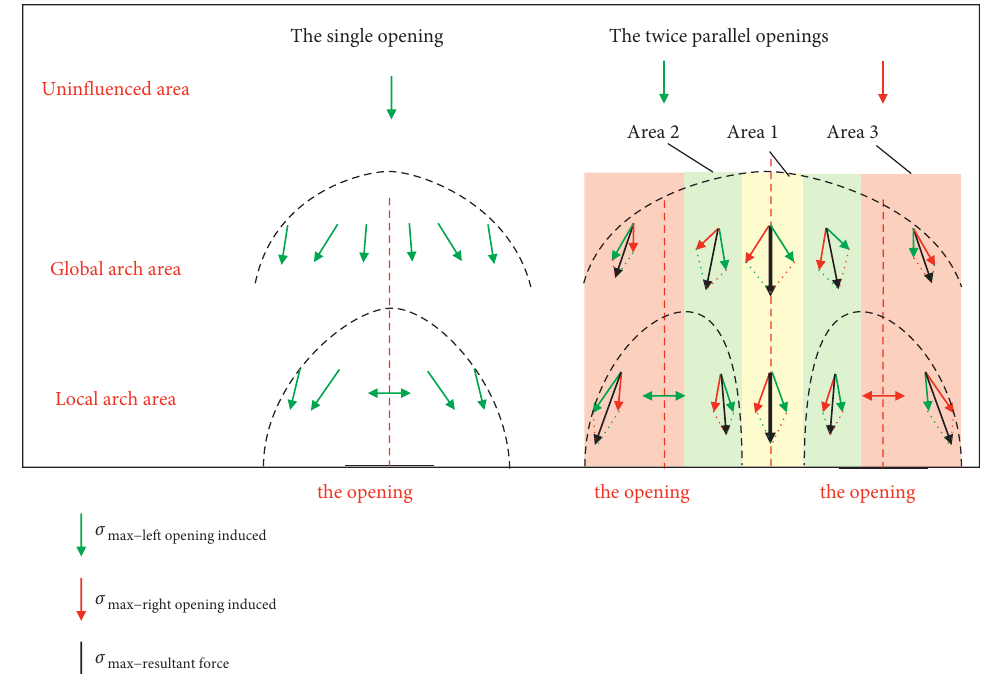
Figure 5: The mechanical analysis of the direction of the maximum principal stress of the rock masses.